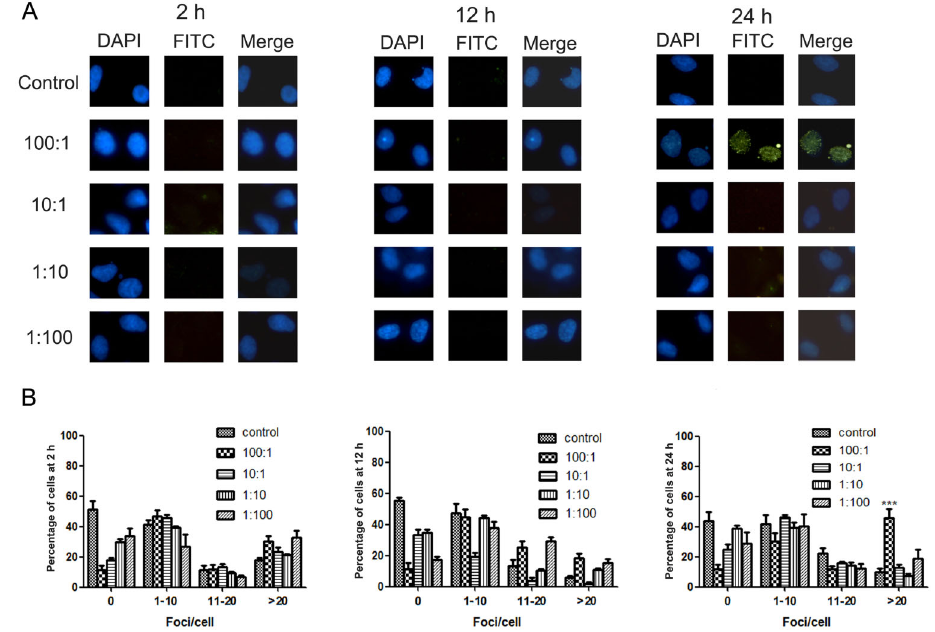
Figure 3. Effects of melamine-cyanuric acid (CA) co-exposure on phosphorylated-H2AX ( g H2AX) foci formation in 293 cells. After melamine-CA treatment with various ratios of melamine-CA for 2, 12, and 24 h, cells were fi xed and stained with anti - g H2AX antibody and subjected to immuno fl uorescence microscopy. A , Representative images from 1 of 4 independent experiments. B , Semi - quanti fi cation of g H2AX-positive cells from panel A . Data are reported as means ± SD. ***P o 0.001, compared to Control (ANOVA). DAPI, 4,6 - diamidino - 2 - phenylindole; FITC, fl uorescein